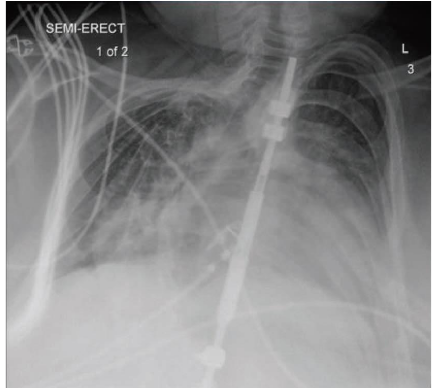
Figure 1: Chest X-ray during Pediatric Intensive Care Unit ad- mission demonstrating enlarged cardiac silhouette, nonspecifc bilateral airspace opacities, perihilar interstitial markings, and haziness of the left costophrenic angle. No evidence of major pleural efusion or pneumothorax. Toracic scoliosis and posterior spinal growing rod are visualized. Suboptimal evaluation related to body